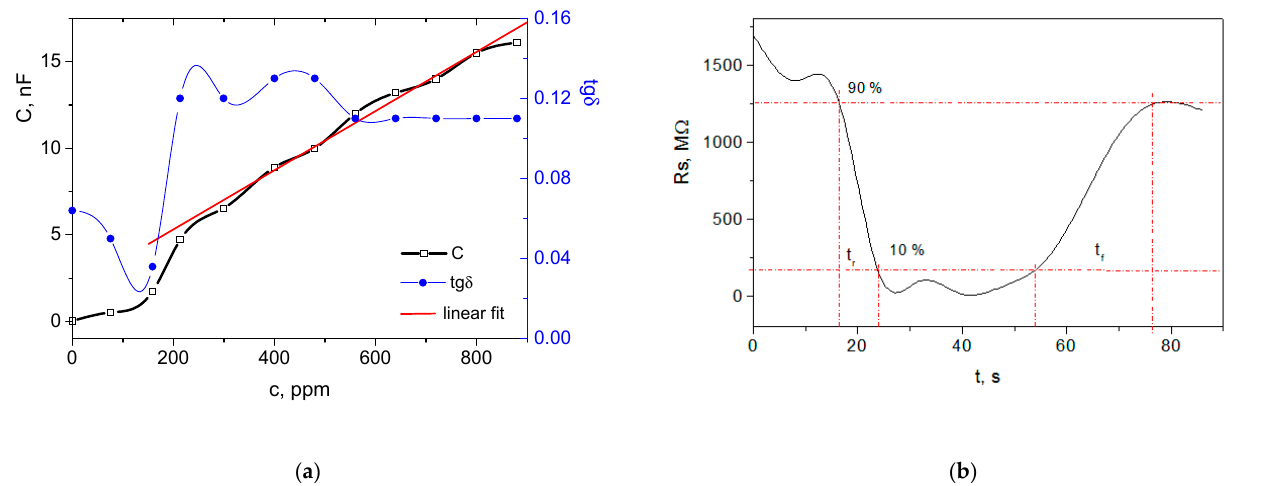
Figure 2. Response of the sensing device with the small meander-patterned membrane: ( a ) capaci- tance and loss tangent changes with the ethanol concentration; ( b ) sensing layer resistance change with the time for response and recovery time determination at 750 ppm.